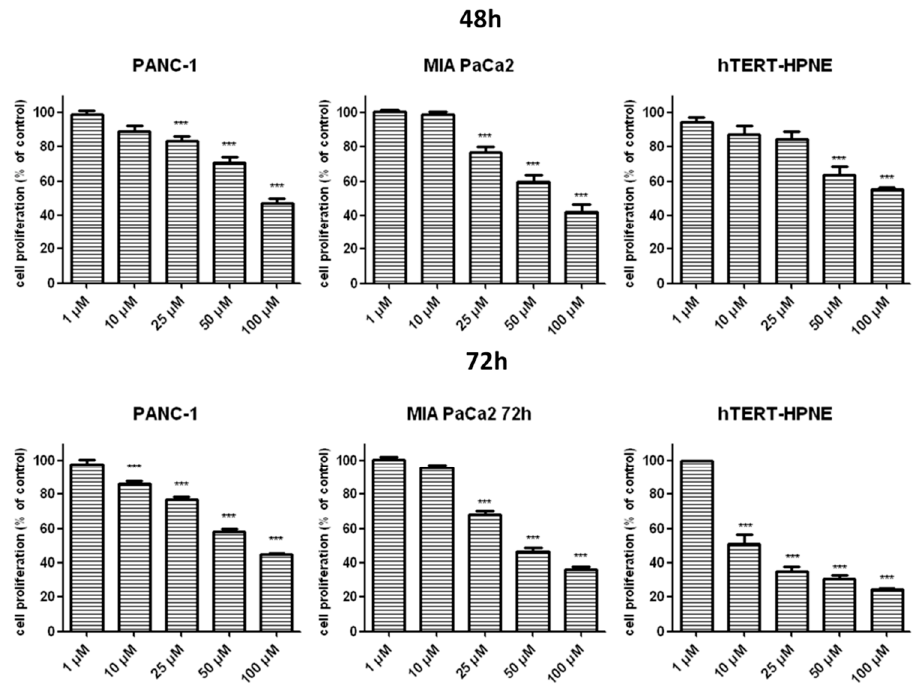
Figure 3. Antiproliferative effects of T1 on pancreas ductal adenocarcinoma cell lines PANC-1, MIA PaCa2 and hTERT-HPNE. Inhibition of PANC-1 and MIA PaCa2 cells proliferation was detected by quantitative ELISA analysis of BrdU incorporation after 48 and 72 h of treatment with vanadium compound. Data are mean ± SD of 3 separate determinations. *** p < 0.001, as compared with untreated